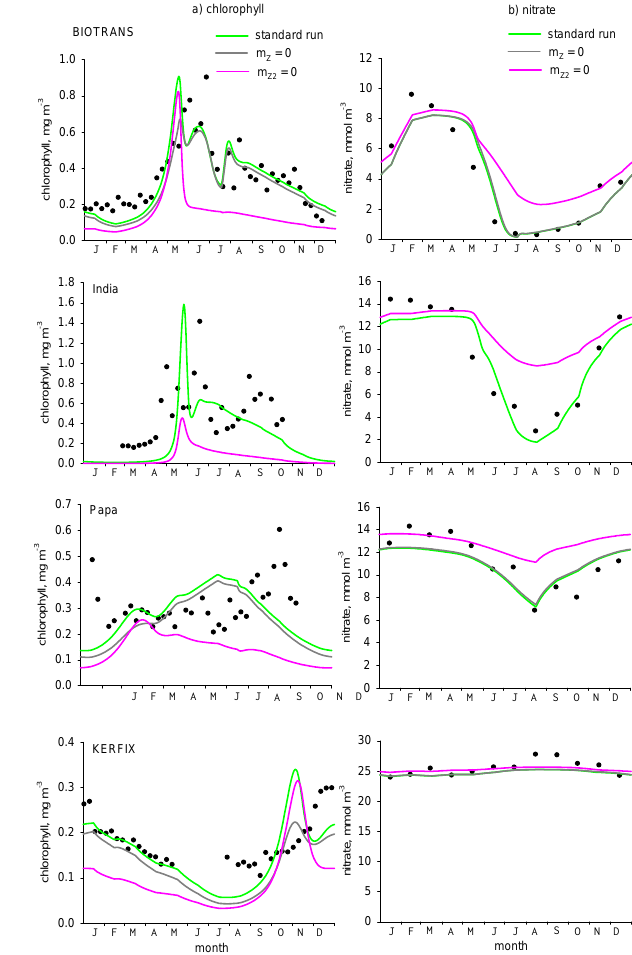
Figure 21. Simulations for all four stations showing model sensi- tivity to phytoplankton mortality. Parameters m P (linear mortality) and m P 2 (quadratic mortality) were set to zero in turn. (a) Chloro- phyll, (b) nitrate.